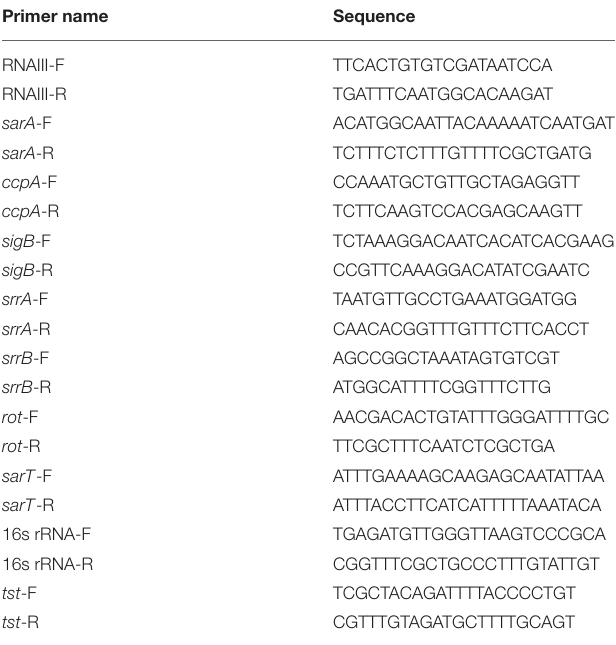
TABLE 1 | qRT-PCR Primers used in this